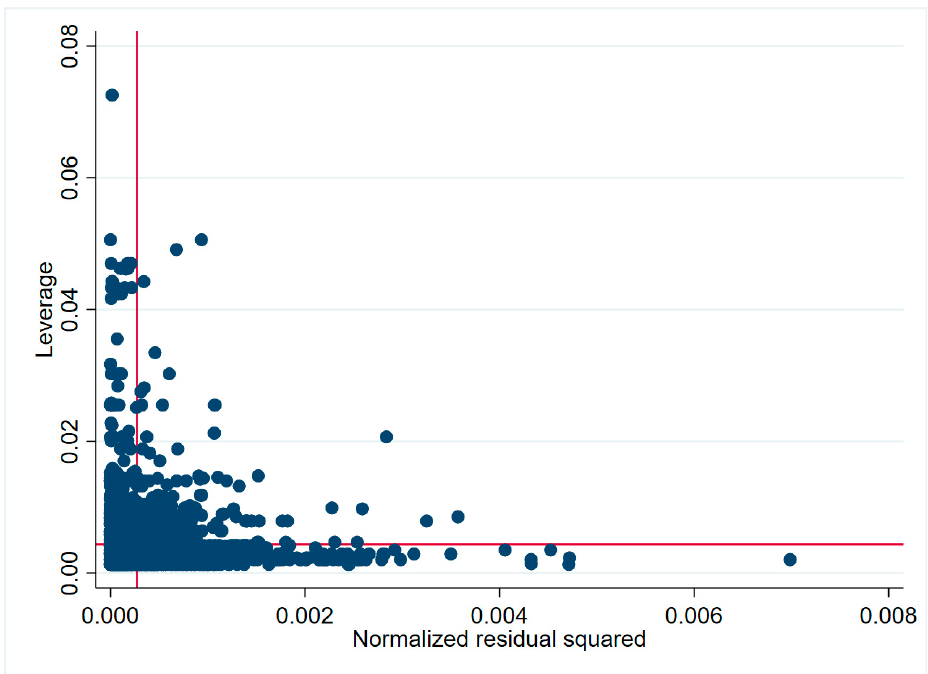
Figure 3. Relationships between residuals and leverages (outliers). Figure notes: leverage is a measure to identify the outlier observations. It ranges between 0 and 1, and a higher leverage score indicates a more influential observation.